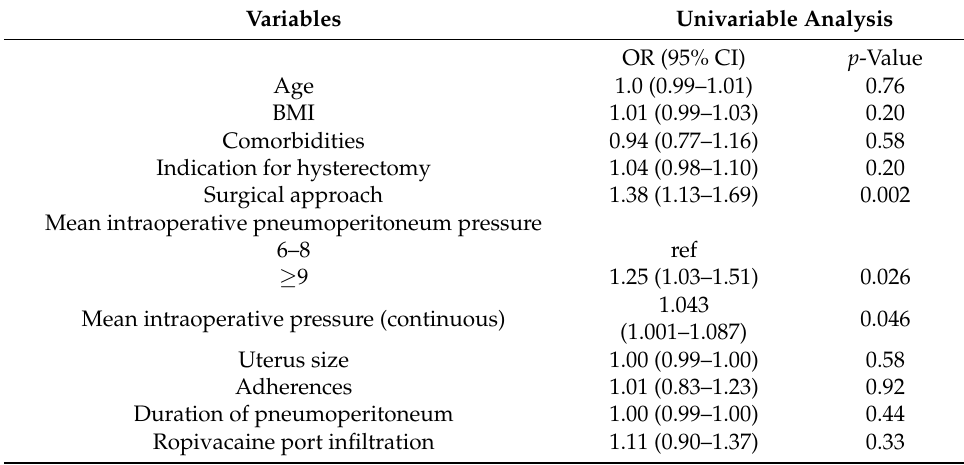
Table 4. Analysis of the factors associated with ever consuming opioids in the postoperative period (PACU, Day 0 or Day 1).